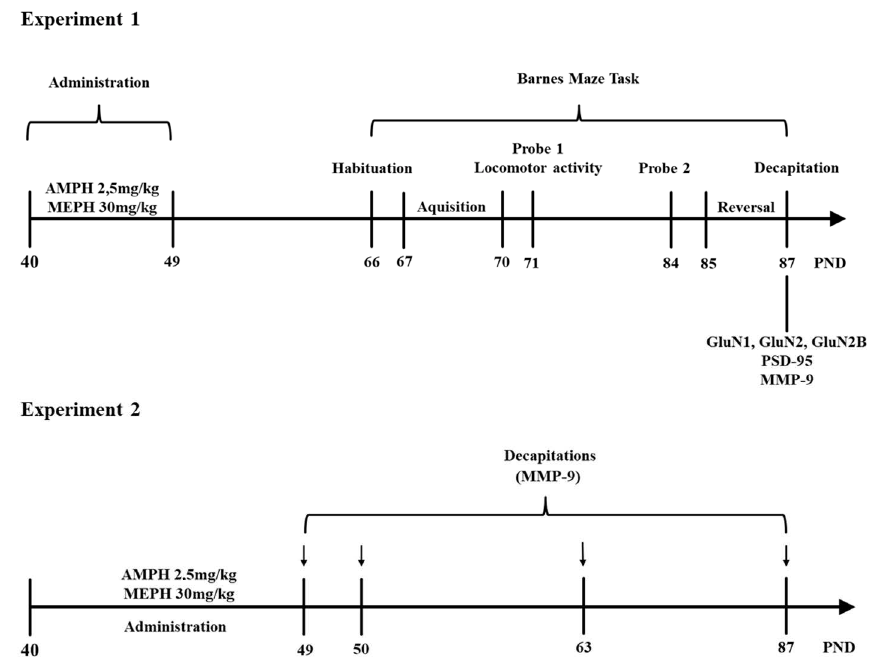
Figure 1. Diagram of experimental designs 1 and 2. AMPH—amphetamine; MEPH—mephedrone; PND—postnatal day; MMP-9—matrix metalloproteinase-9. PND—postnatal day; MMP-9—matrix